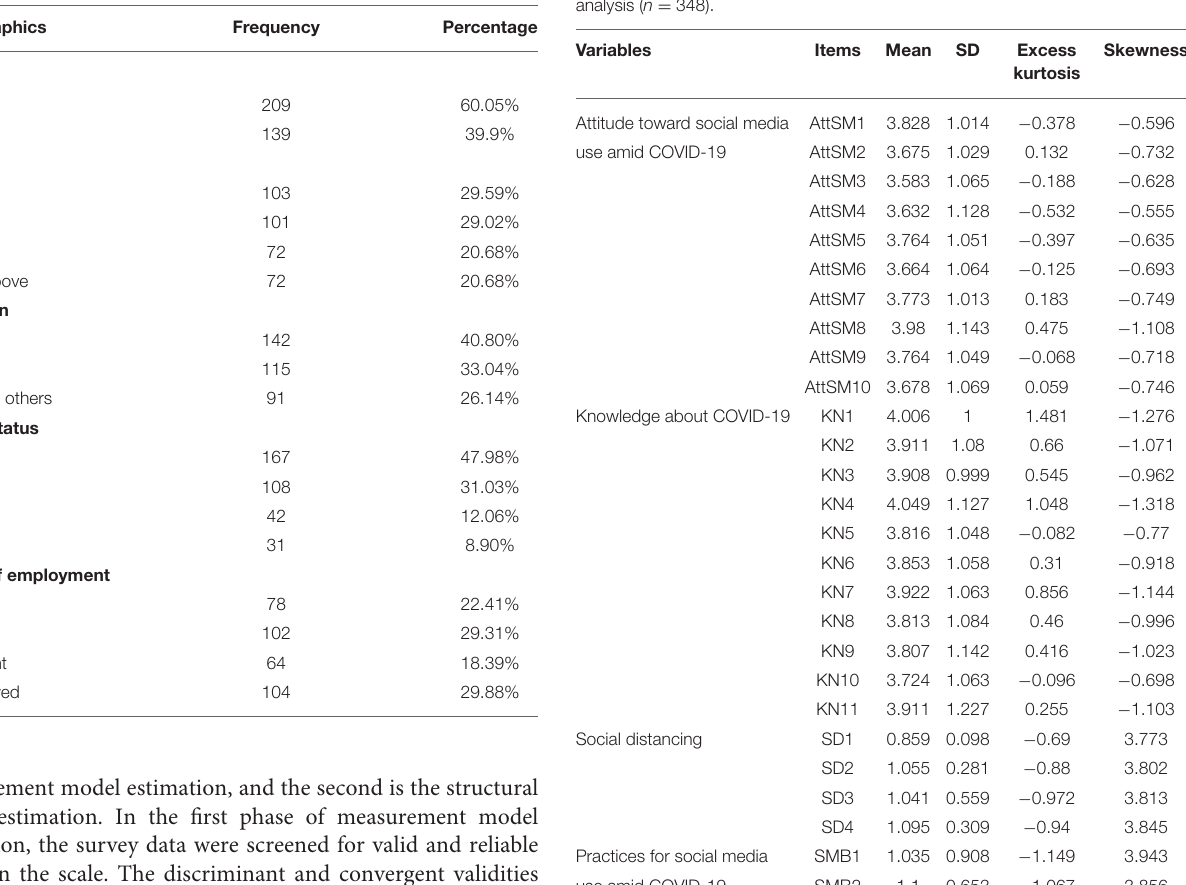
TABLE 1 | Demographic analysis. TABLE 2 | Mean, standard deviation (SD), excess kurtosis, and skewness